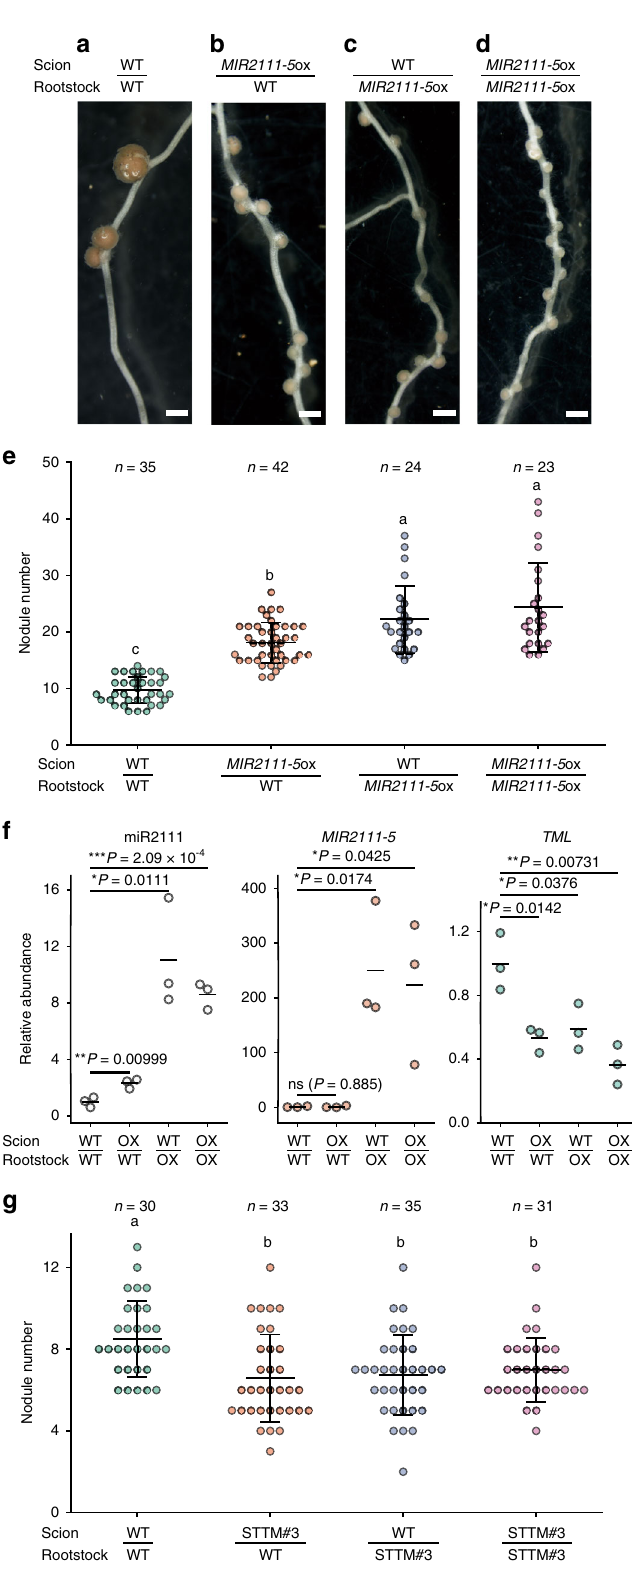
nodule formation. As for MIR2111-3 expression patterns 12 , pro- MIR2111-5:GUS expression was observed in the phloem of leaves (Fig. 3a, c, d) but not in stems, roots, or nodules (Supplementary Fig. 3). The accumulation of MIR2111-5 was hardly detected in roots using qRT-PCR (Fig. 3h). Considering this